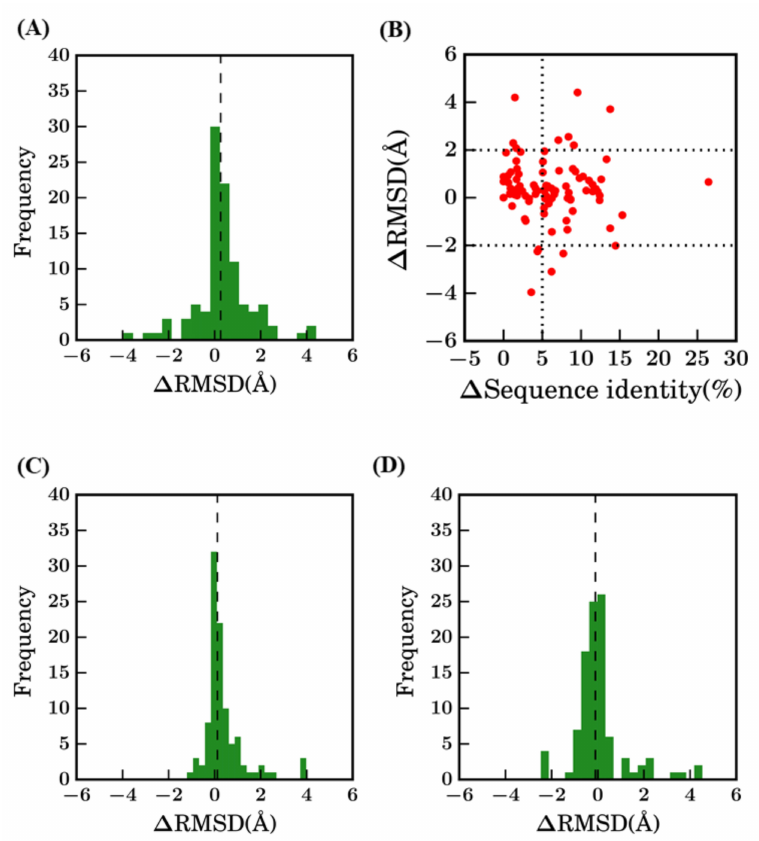
Figure A2. Difference between selected models. Difference between RMSD ( ∆ RMSD) of selected models ( A ) between bestSeqIdTemp —scenario 1 and bestStructTemp —scenario 2, ( C ) between scenario 1 and scenario 3— 3bestSeqIdTemp , and ( D ) between scenario 2 and scenario 3. ( B ) ∆ Sequence identity (%) (between query and template sequences of scenario 1 and scenario 2) vs ∆ RMSD (selected model with the original crystal structure).